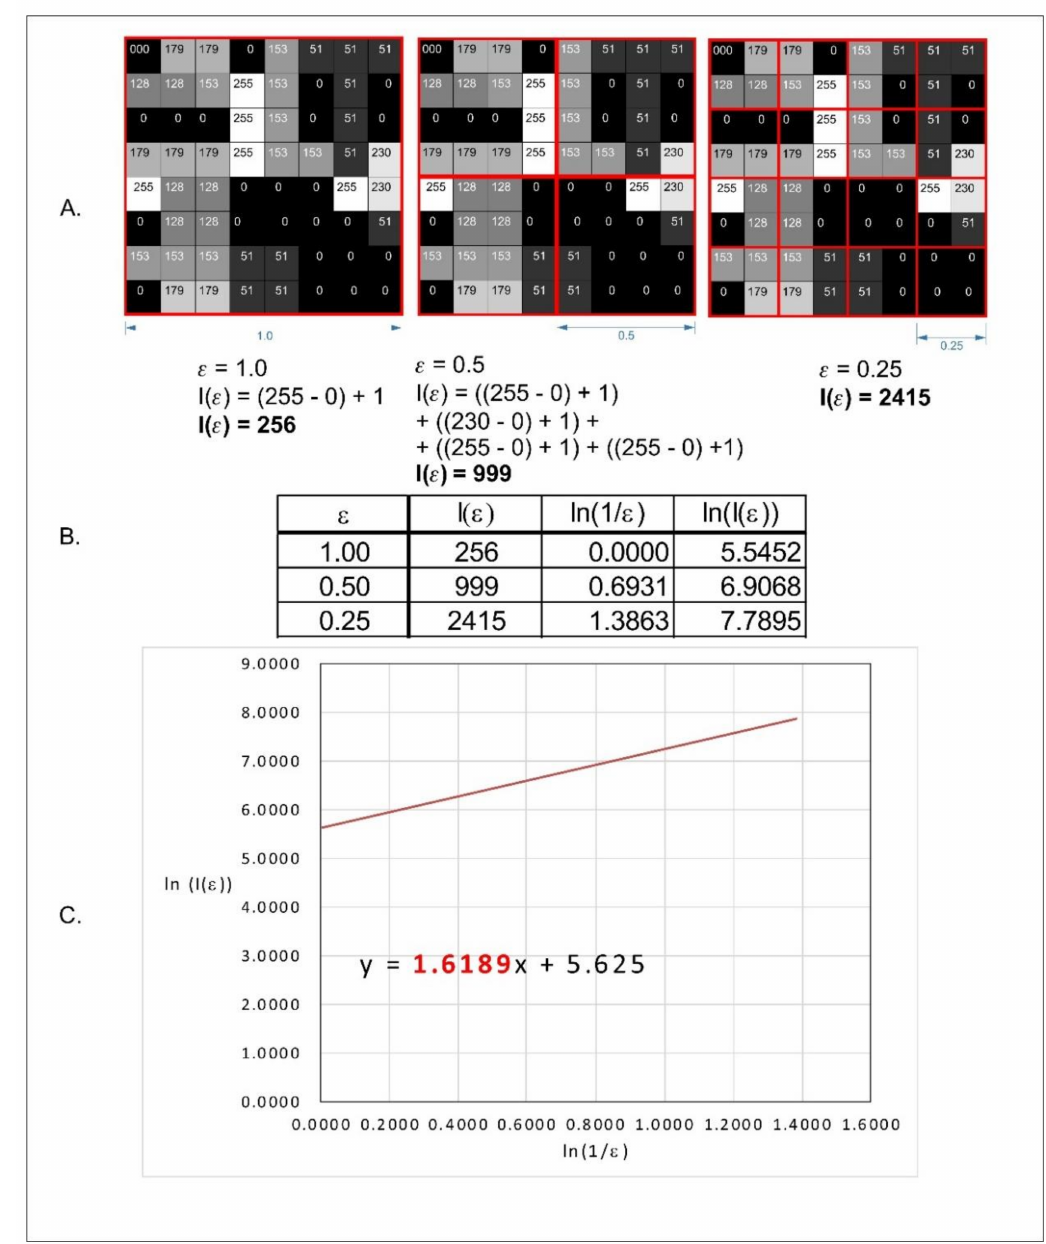
Figure 2. Graphical interpretation of intensity difference algorithm of fractal dimension counting. ( A ) Grayscale 8 bits analyzed image, numbers in squares represent intensity level of each pixel, 0 is black, 255 is white. Red squares represent scale— ε . ( B ) Values of intensity difference for each step of scale reduction ( ε = 1.0, ε = 0.5, ε = 0.25). ( C ) Straight line drawn through points from table B on the x–y chart in natural logarithm scale. Slope factor of this straight line is a value fractal dimension calculated by the intense difference